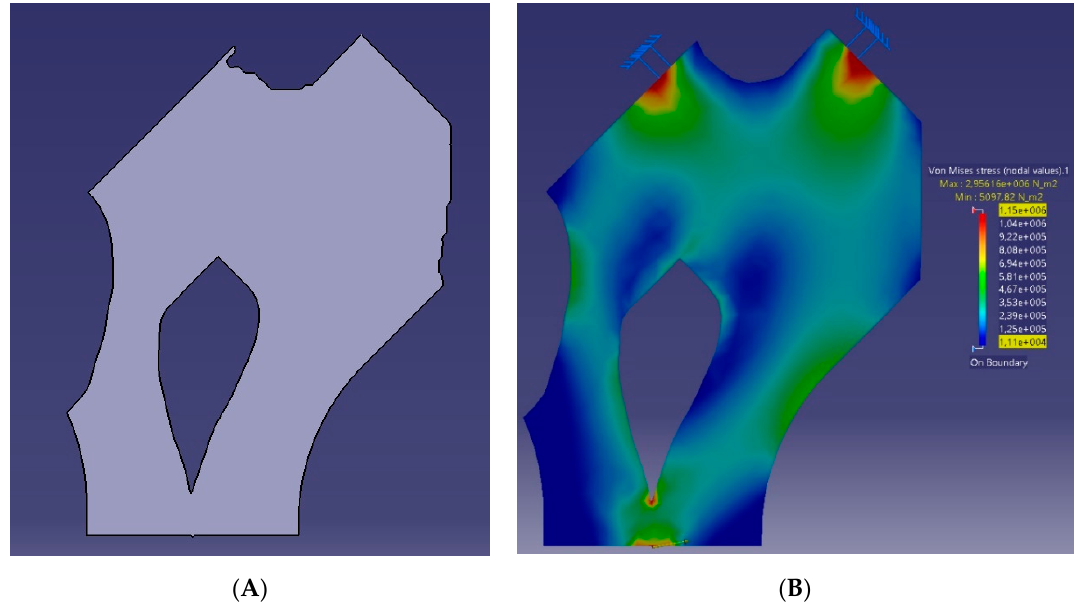
Figure 14. ( A ) AM shaped part and ( B ) developed stresses.